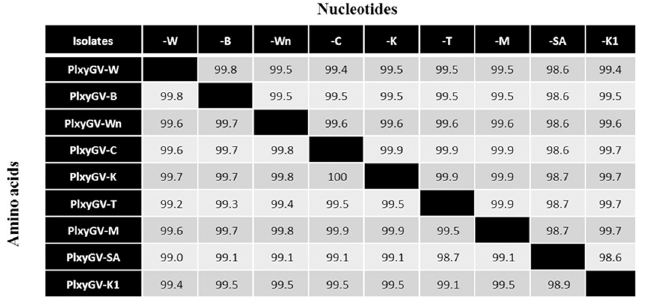
Fig 2. Identity of genome sequences between nine PlxyGV isolates. The complete nucleotide sequences of nine PlxyGV genomes and concatenated amino acid sequences encoded by the PlxyGV genomes were aligned separately, and the identity levels between the genomes are expressed as percentage. The amino acid sequences of ORF9, 13, 26, 39, 49, 95 and 108 were not included. W, PlxyGV-W; B, PlxyGV-B; C, PlxyGV-C; K, PlxyGV-K; T, PlxyGV-T; M, PlxyGV-M; SA, PlxyGV-SA; K1, PlxyGV-K1.